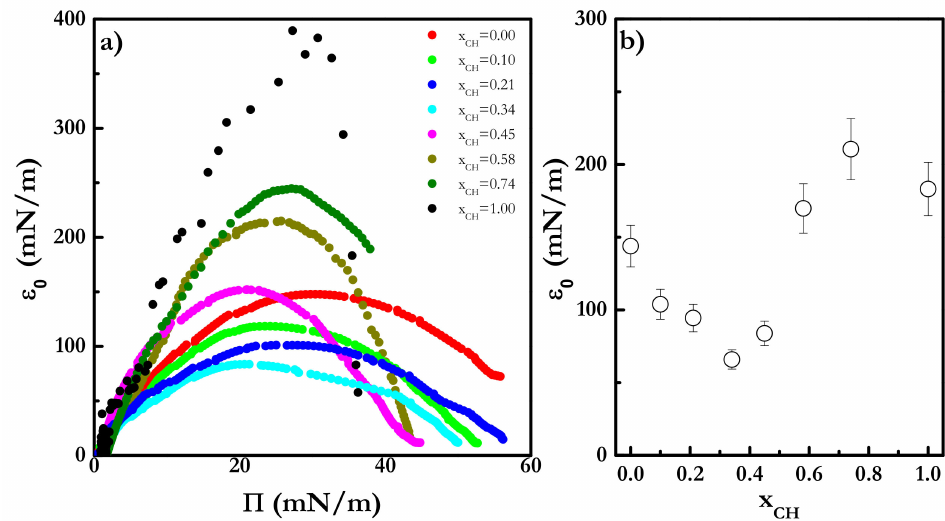
Figure 8. ( a ) Quasi-static dilational elasticity, ε 0 , dependences on the surface pressure, Π , for Langmuir monolayers of mixtures of CH and CE spread at the water/vapor interface at 35 ◦ C. ( b ) Dependence of the quasi-static dilational elasticity, Π = 35 mN/m at 35 ◦ C. ε 0 , on the CH molar fraction, x CH , at